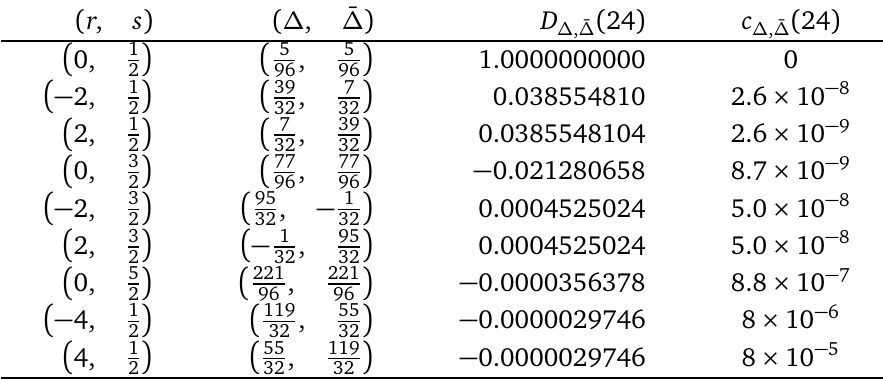
Table 10: Computing the means and coefficients of variations of structure constants for the spectrum (cid:83) at c = 0 with 20 choices of the points { z 2 (cid:90) , (cid:90) + 1 2